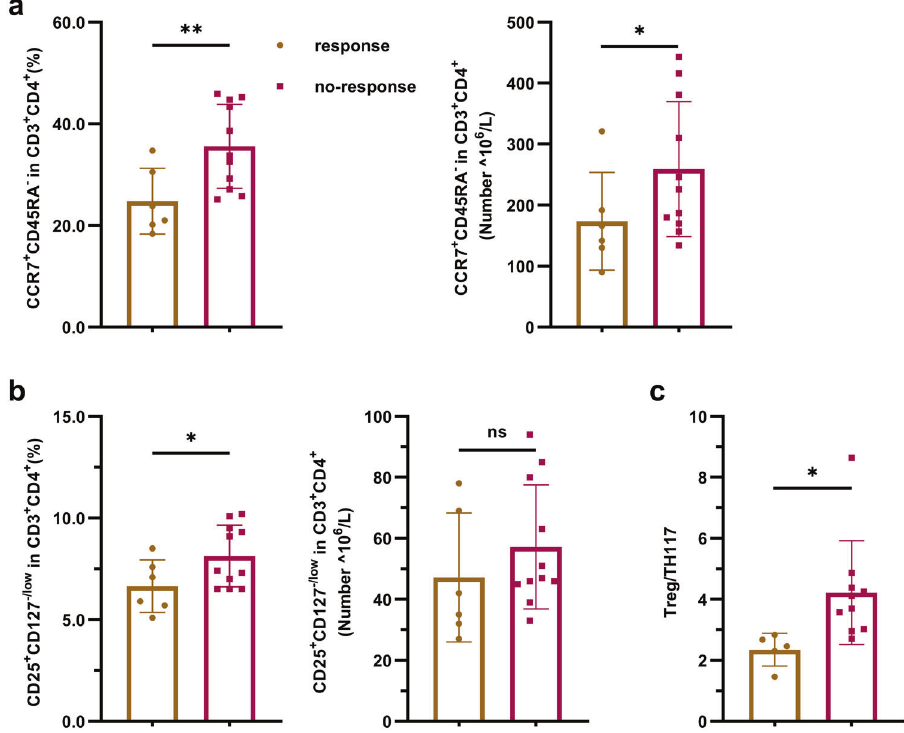
Fig. 6 Baseline immune indices in PB in response group and no-response group. a Baseline level of CD4 + TCM cells. b Baseline level of Tregs. c Baseline level of the ratio of Treg/Th17 (response group: n = 6, no-response group: n = 11, * P < 0.05; ** P < 0.01) Signal Transduction and Targeted Therapy (2022)